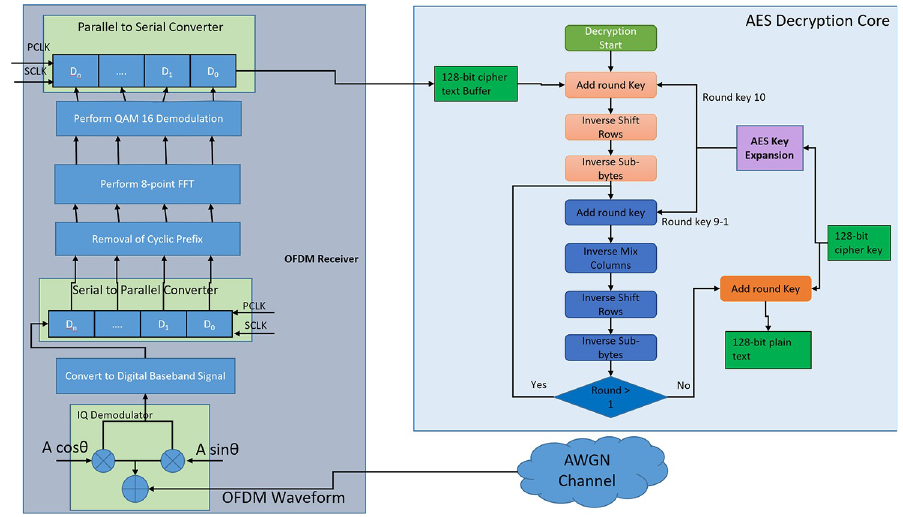
Fig 6. Flowchart of the AES based wireless receiver